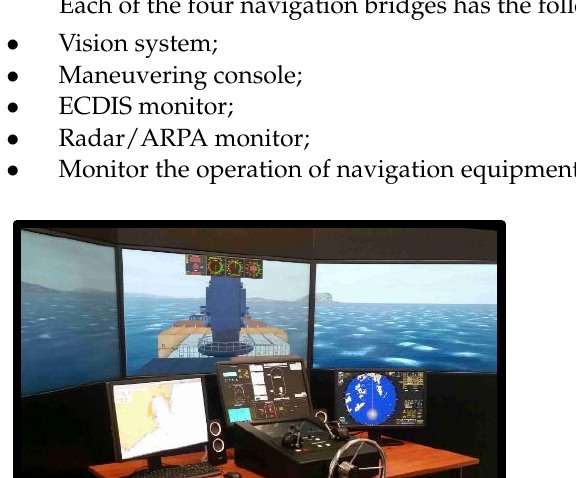
Figure 3. View of simulator navigation bridge.